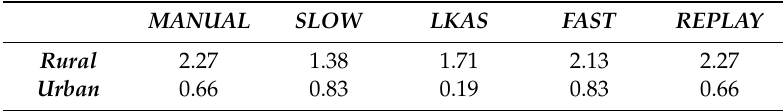
Table 3. The 95th percentile of absolute values of lateral jerk (m / s 3 ) for di ff erent drives across di ff erent road